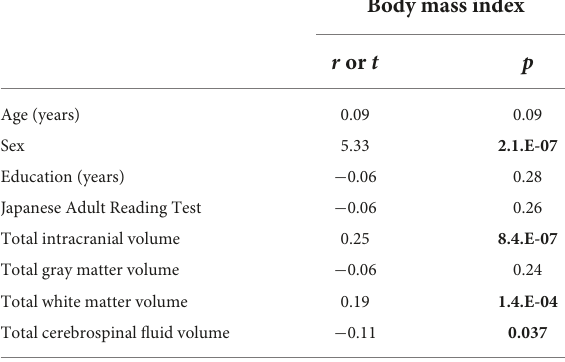
TABLE 4 The correlations between body mass index and the variables. Figure 1D ). There was no significant correlation between BMI